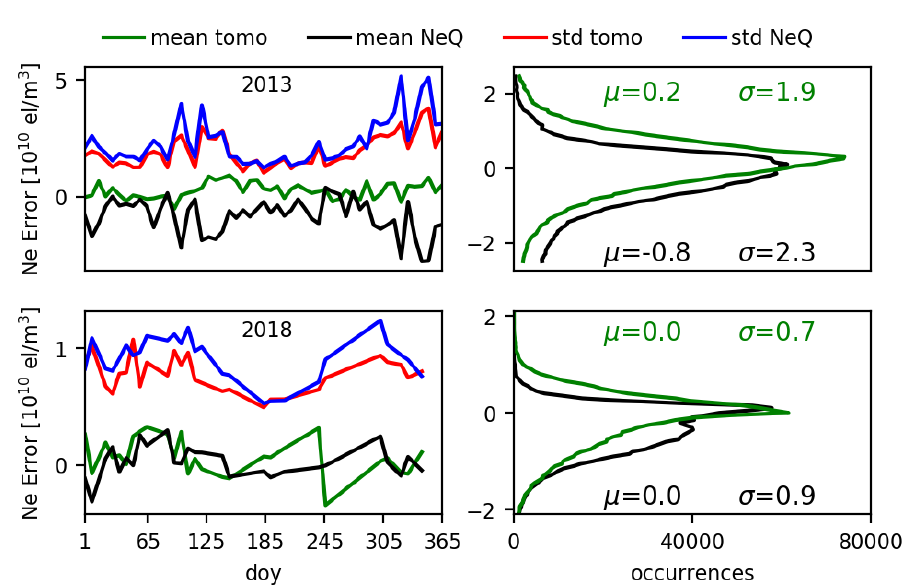
Figure 11. Electron density errors of the tomography and NeQuick with respect to the DMSP 15 satel- lite data. The left panel shows the temporal series of the standard deviations and daily averages of the errors computed for 2013 ( top ) and 2018 ( bottom ). The right panel shows the histogram of the errors together with the total error mean ( µ ) and standard deviation ( σ ) of the